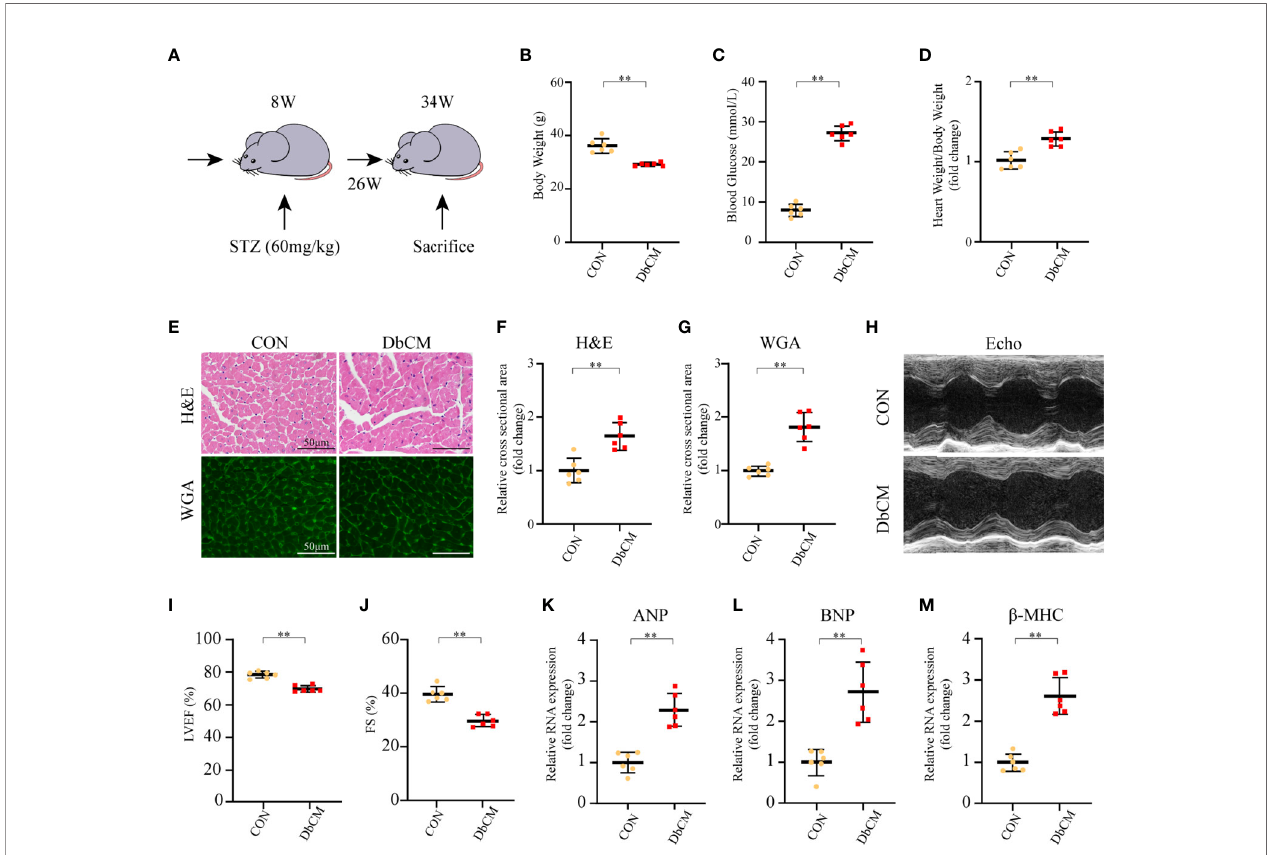
FIGURE 5 | Establishment of diabetic cardiomyopathy mouse model. (A) Schematic illustration of diabetic cardiomyopathy mouse model. (B – D) Body weight, random blood glucose, and heart weight/body weight at 26 weeks after STZ injection (n=6 each). (E) Representative images of H&E staining and WGA staining in the hearts of CON and DbCM mice (n=6; scale bar, 50 m m). (F) Statistical results of the myocyte cross-sectional areas of H&E staining (n=6, at least 100 cells per mouse were analyzed). (G) Quantitative analysis of myocyte cross-sectional areas of WGA staining (n=6, at least 100 cells per mouse were